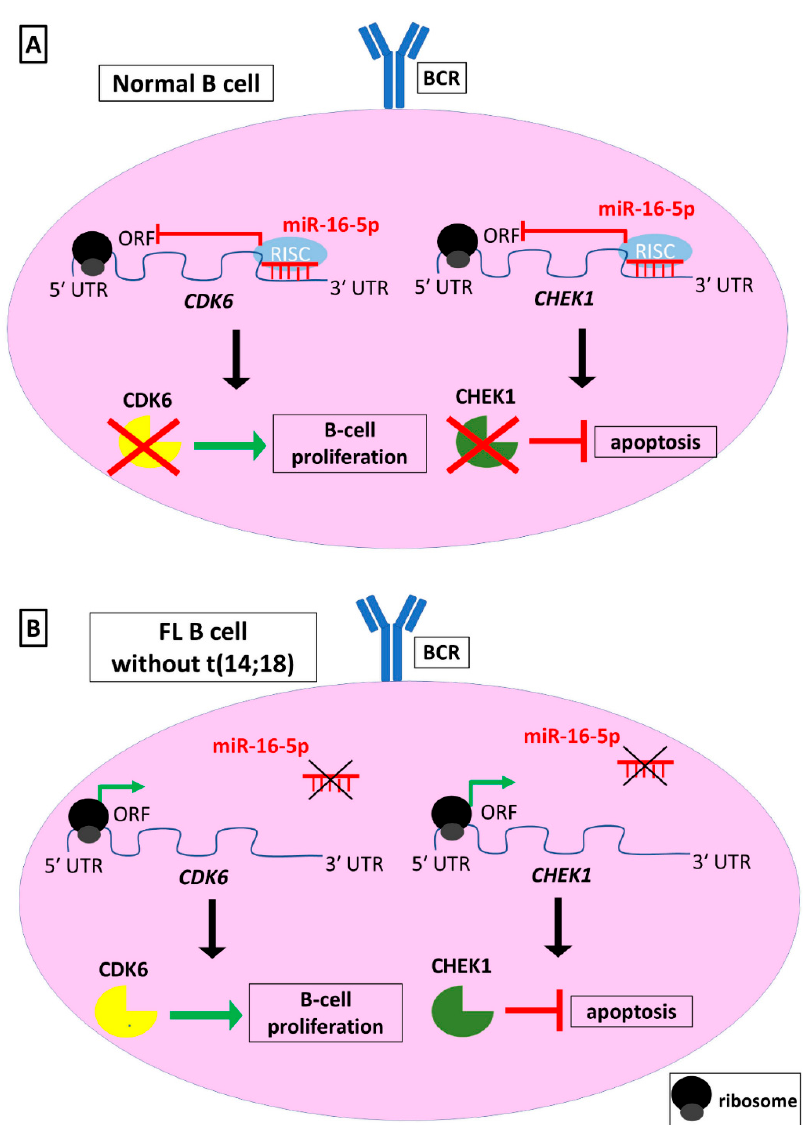
Figure 3. One of the potential effects of miR ‐ 16 ‐ 5p in normal B cells ( A ) and follicular lymphoma (FL) B cells without t(14;18) ( B ). In the physiological state, its expression levels are high; miR ‐ 16 ‐ 5p suppresses the expression levels of its target genes, CHEK1 and CDK6 , leading to apoptosis and cell cycle arrest. On the contrary, in a FL B cell, the expression levels of miR ‐ 16 ‐ 5p are low, leading to increased expression of its targets. This results in B ‐ cell apoptosis inhibition and increased proliferation rate, two hallmarks of a malignant cell. Black arrows indicate the transition to the next step; red “reverse tau” symbols ( ⊥ ) indicate inhibition, whereas green arrows indicate promotion of a cellular process. Abbreviations: BCR, B ‐ cell receptor; RISC, RNA ‐ induced silencing complex.